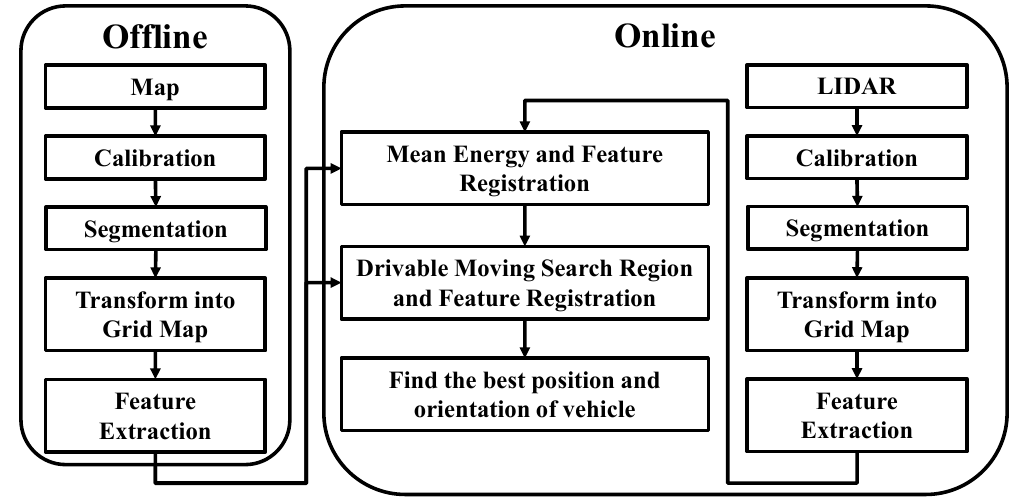
Figure 1. Flow chart of the localization algorithm.